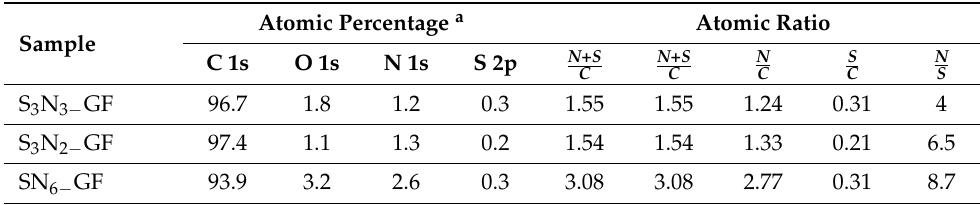
Table 2. XPS atomic percentages for all prepared materials.